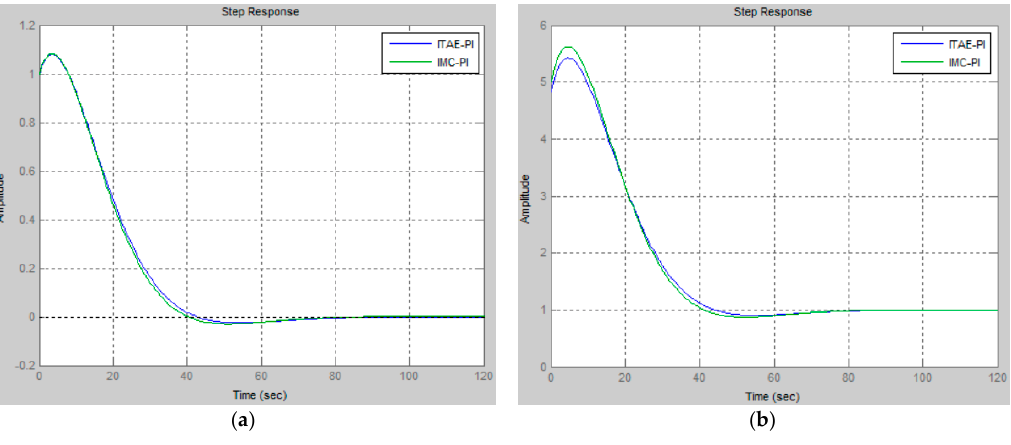
) ; ( b ) R = H R H F R S